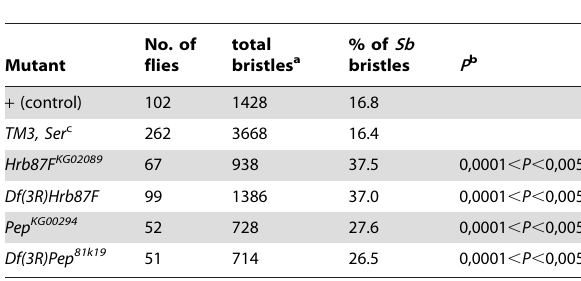
Table 1. Dominant effects of Hrb87F and PEP mutations on Stubble variegation of T(2;3)Sb v